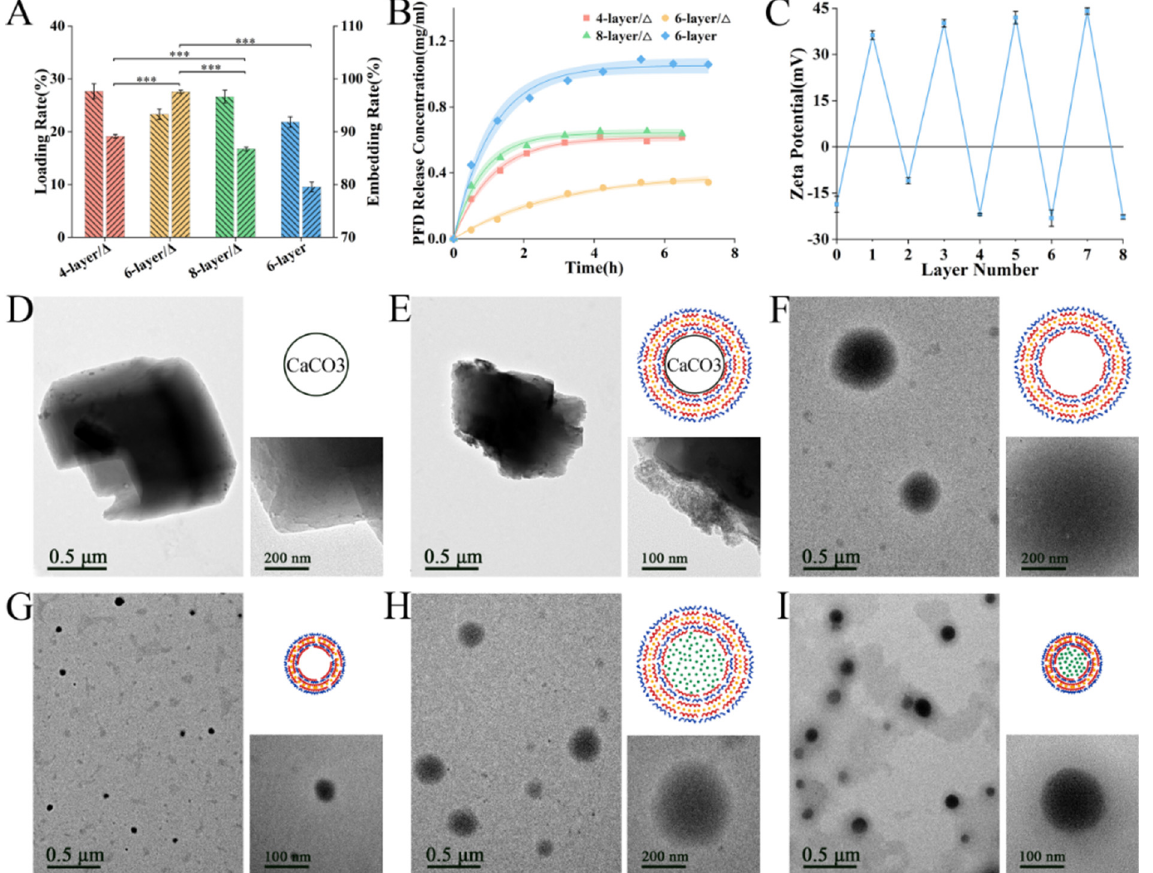
Figure 1. ( A ) Loading rate, embedding rate and ( B ) PFD release rate of heated 4/6/8-layer NCs and unheated 6-layer capsules; ( C ) Zeta potential of each layer in NC’s shell; TEM and schematic of ( D ) CaCO 3 templates, ( E ) capsules with templates, ( F ) hollow capsules, ( G ) heated hollow NCs, ( H ) loaded capsules and ( I ) heated loaded NCs. (***, p < 0.0001)